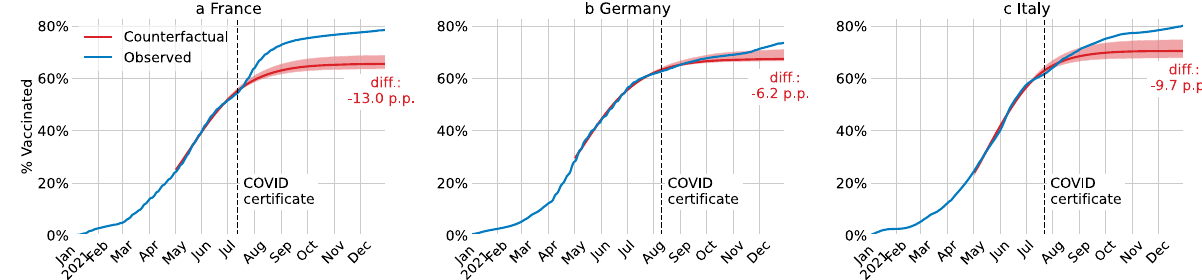
Fig. 1 Estimated vaccine uptake with and without COVID certi fi cates. For France ( a ), Germany ( b ), and Italy ( c ), cumulative share of the population who received at least one COVID-19 vaccine dose in the actual intervention deployment (blue) and in the no-intervention counterfactual scenario (red). The red shaded area is the 95% con fi dence interval centred around the main estimate. The black dashed vertical line is the date of the announcement